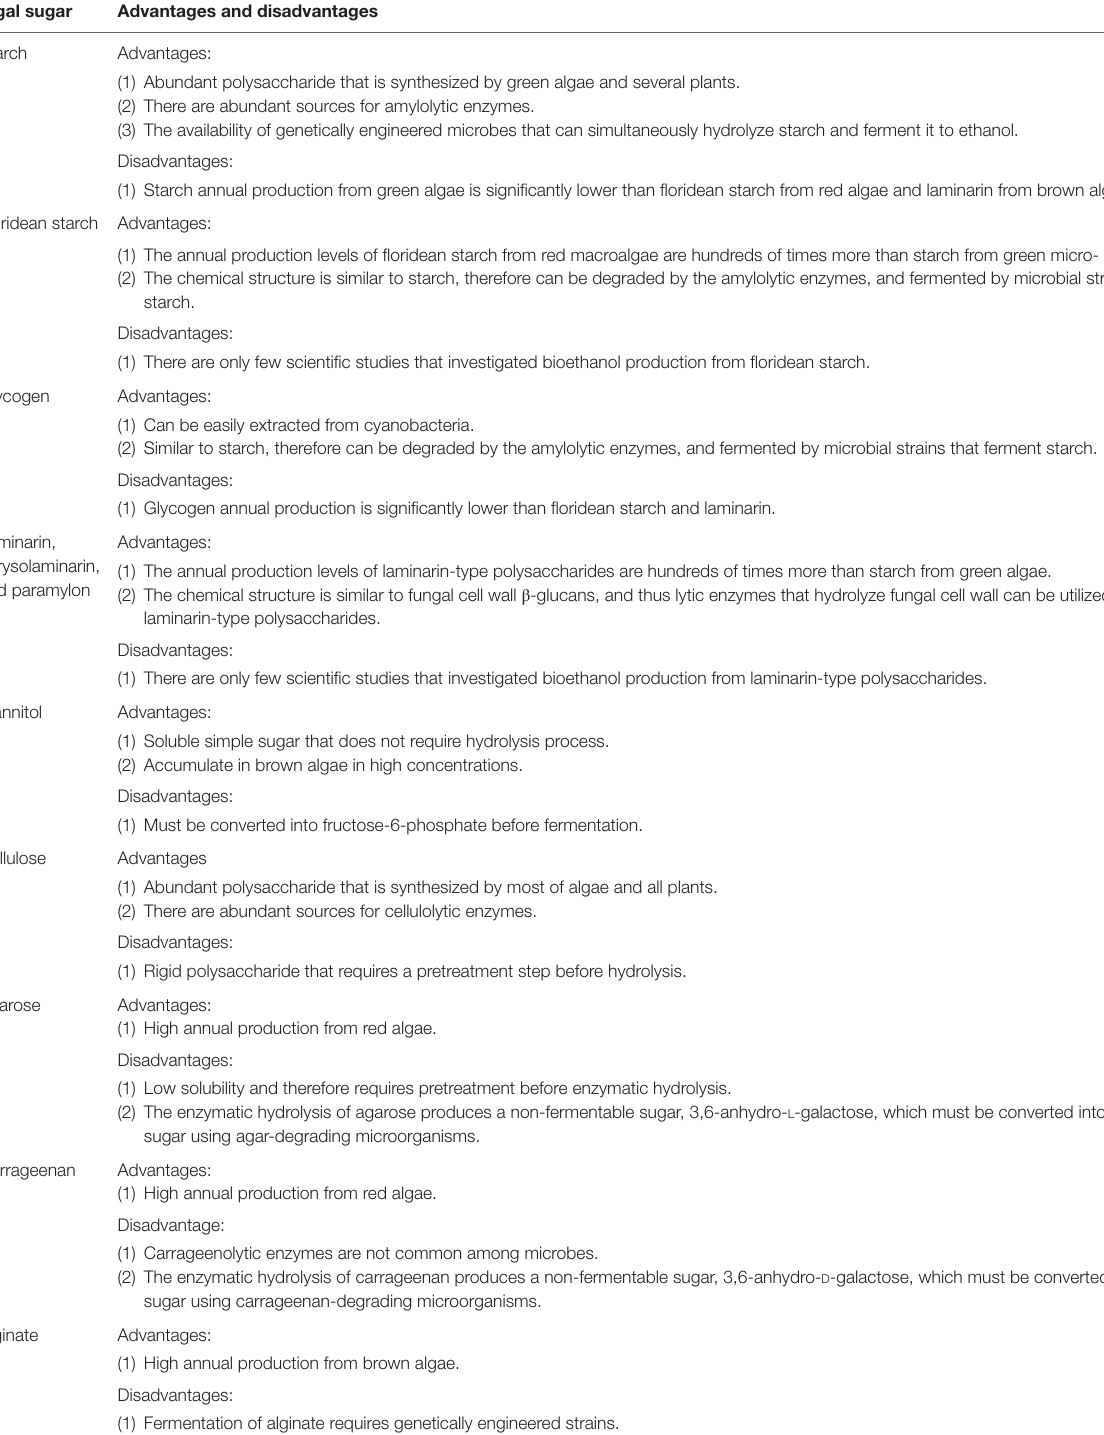
TABLe 3 | The advantages and disadvantages of employing different algal sugars for the production of third-generation biofuels. Algal sugar Advantages and disadvantages